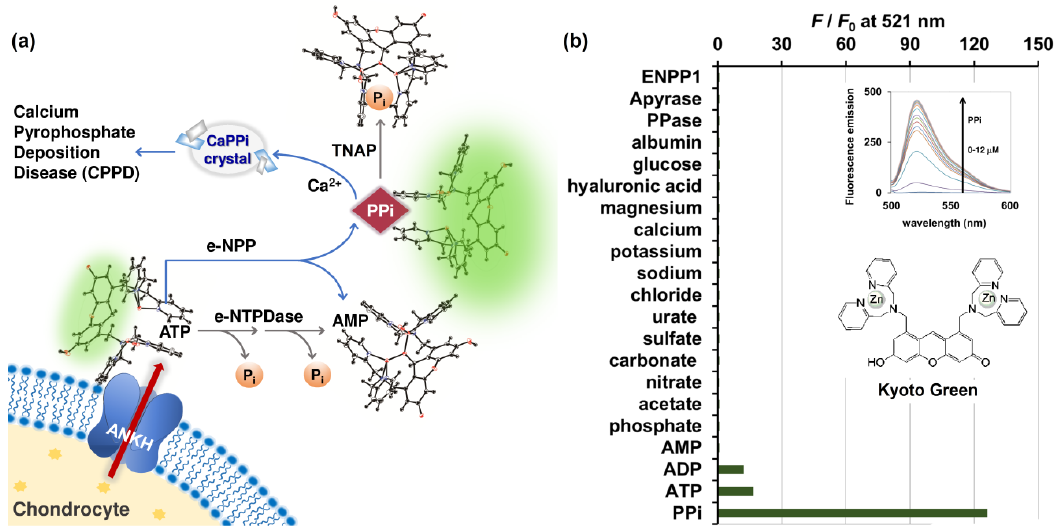
Figure 1. ( a ) Schematic illustration of ATP conversion pathways occurring in biological synovial fluid differentiated using PPi-specific Kyoto Green; ( b ) Selectivity of Kyoto Green (1 μ M) towards various ions (2 μ M), hyaluronic acid (3 mg/mL), glucose (3 mg/mL), albumin (20 mg/mL), PPase (0.4 ng/ μ L), apyrase (4 ng/ μ L), and ENPP1 enzymes (1 ng/ μ L) commonly found in biological synovial fluids. Measurement conditions: 50 mM HEPES buffer, 10 mM NaCl, 1 mM MgCl 2 (pH 7.4, 25 °C, λ ex = 488 nm); (inset, top) Fluorescence emission change of Kyoto Green upon addition of PPi; (inset, bottom)